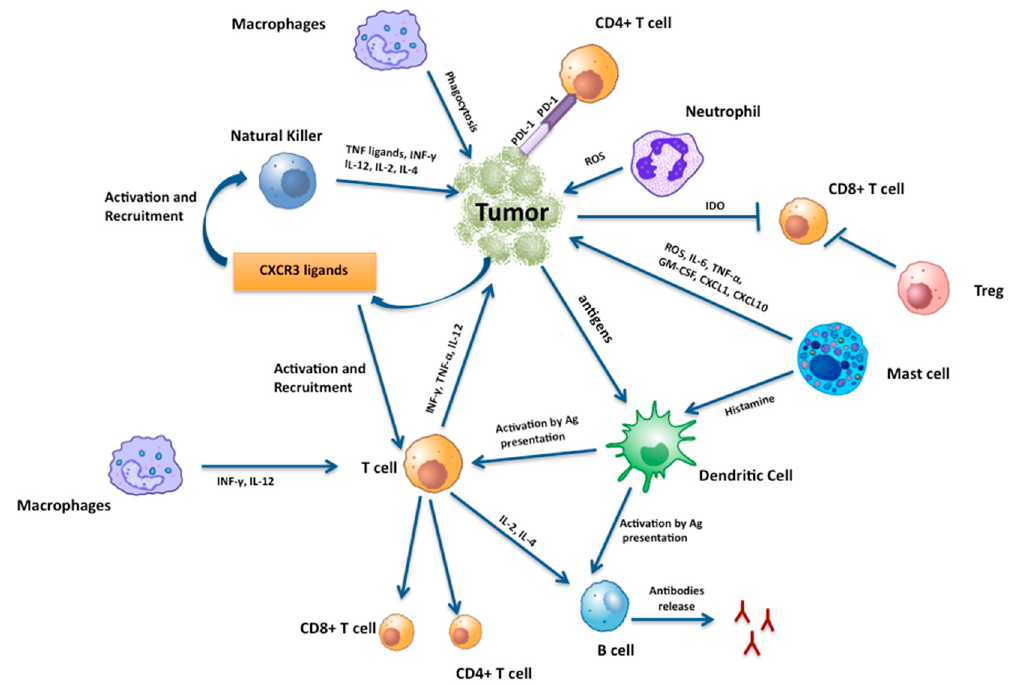
Figure 2. A schematic view of tumor-infiltrating immune cells interactions among each other and with the thyroid cancer cells.